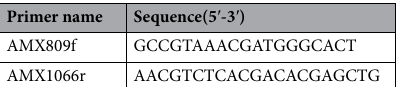
Table 1. Information of PCR primers used in this study.